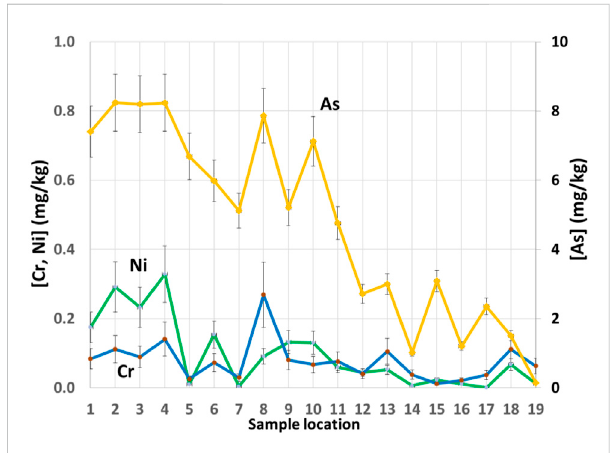
FIGURE 3 Spatial distribution of As, Ni and Cr content in dusts collected from the Abu Dhabi-Liwa Highway.